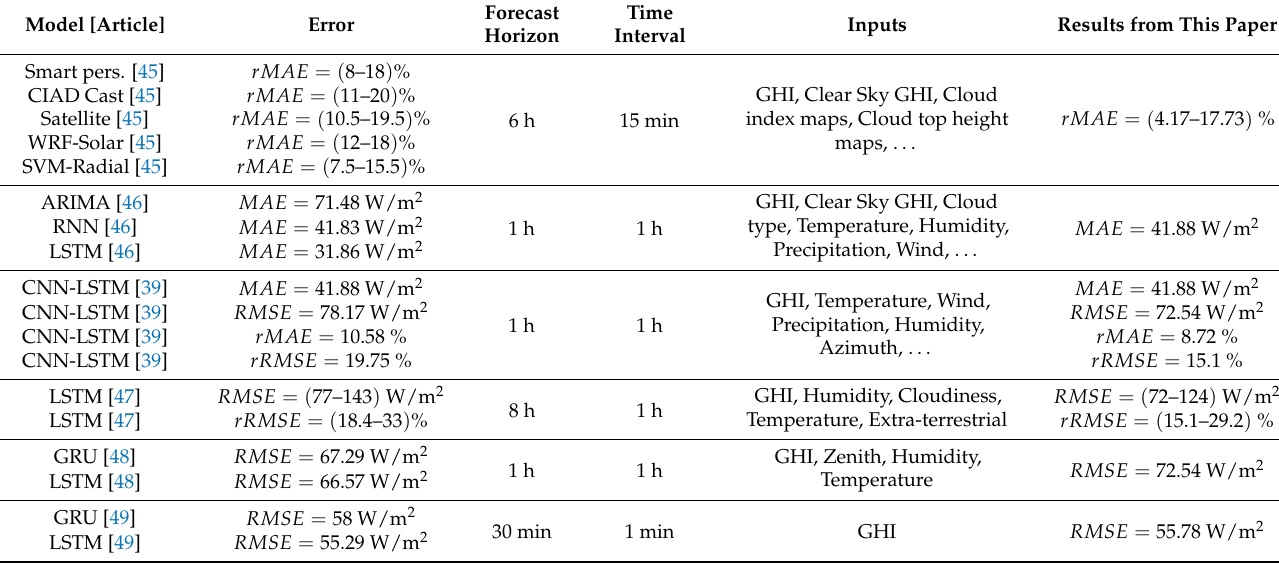
Table 3. Comparison between the research results from this paper and those from other articles in the literature. Forecast Time Inputs Results from This Error Horizon Interval